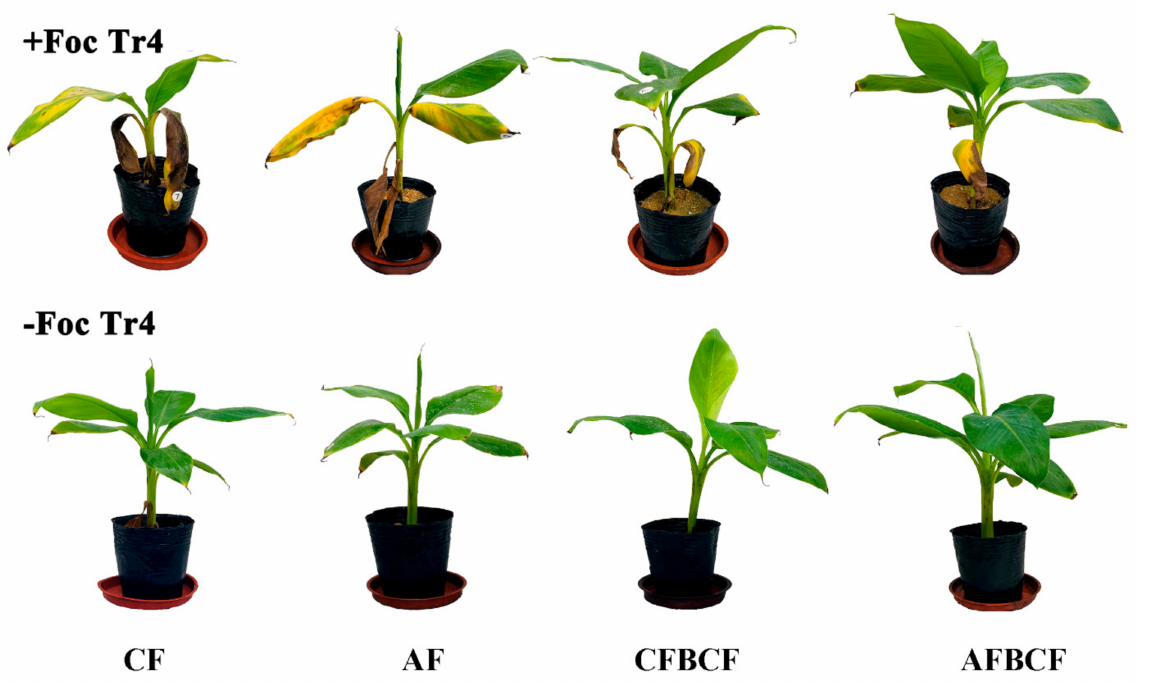
Figure 1. Comparison of banana growth state 60 days after Foc Tr4 inoculation. CF stands for conventional fertilizer. AF stands for alkaline fertilizer. CFBCF stands for conventional fertilizer and biocontrol fungi. AFBCF stands for alkaline fertilizer and biocontrol